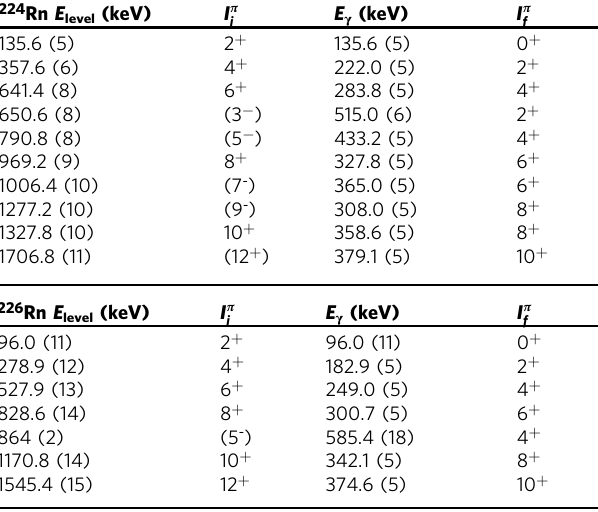
Table 1 Energies of levels and transitions in 224 Rn and 226